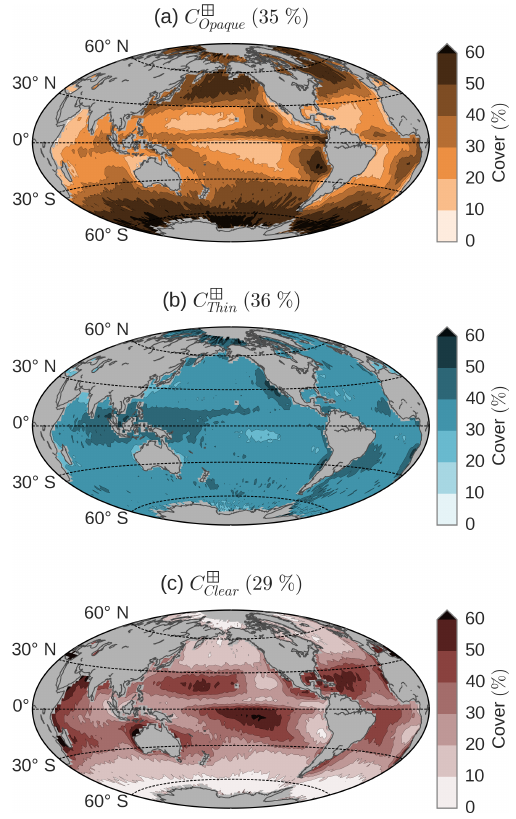
Figure 2. Maps of (a) opaque-cloud cover, (b) thin-cloud cover, and (c) clear-sky cover. Only nighttime over ice-free oceans for the 2008–2015 period is considered. Global mean values are given in